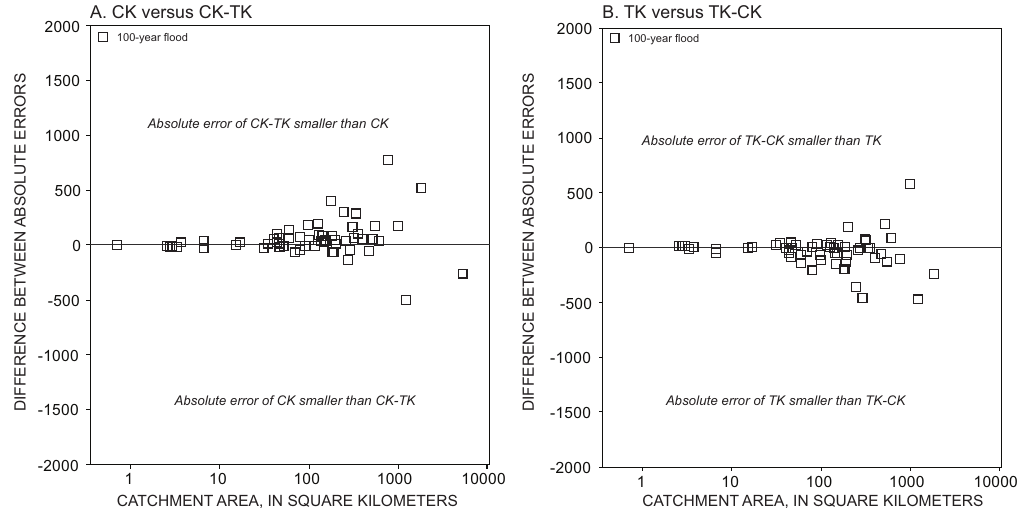
Fig. 5. Differences in absolute error resulting from the application of (A) canonical kriging and the coupling of canonical kriging with topological kriging of the residuals (CK-TK), and (B) topological kriging and the coupling of topological with canonical kriging of the residuals (TK-CK) by catchment area for the 100yr flood